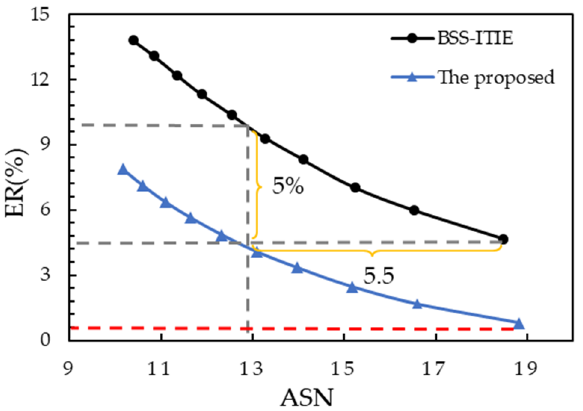
Figure 6. Comparison of the ER and ASN between the BSS-TIIE [28] method and the proposed algorithm.